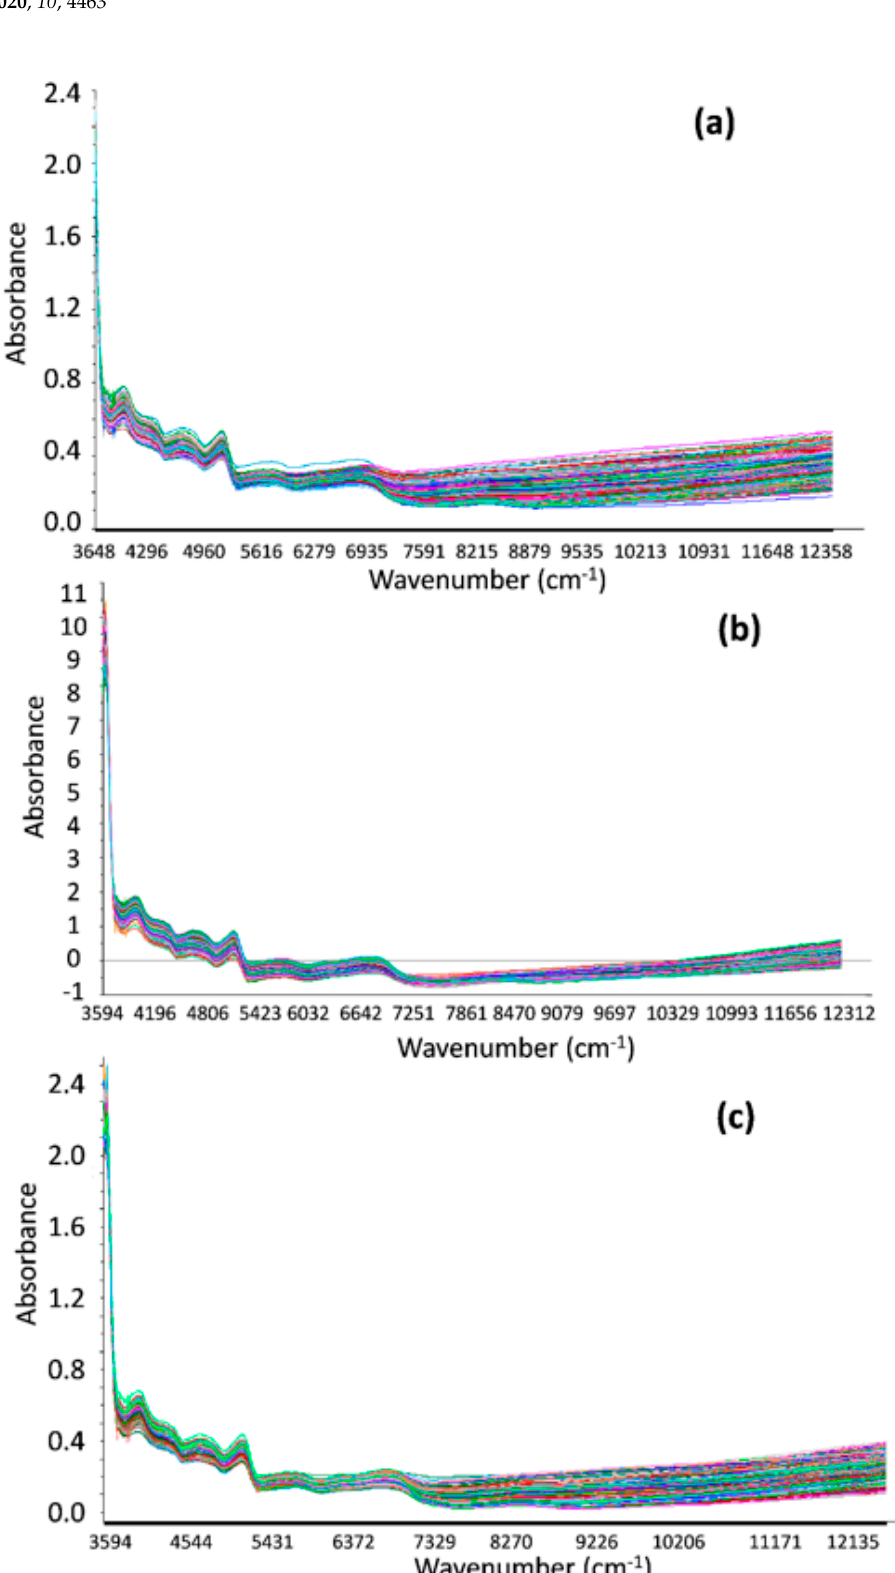
Figure 4. Optimized NIR spectra in the wavenumber region 3594 to 12,358 cm − 1 (2782 to 809 nm) for ( a ) CP, ( b ) NDF, and ( c ) the PQI.